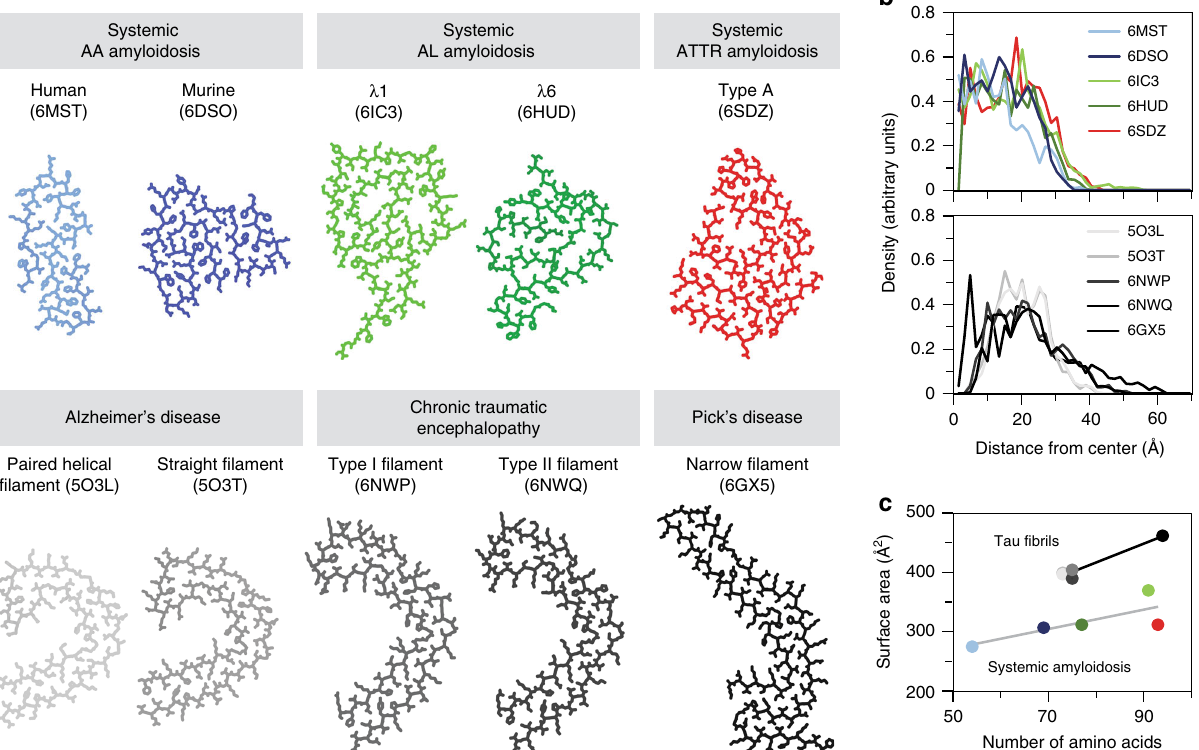
Fig. 5 Comparison of amyloid fi brils from systemic amyloidosis with tau-derived fi brils. a Views of the cross-sectional layers of fi ve fi brils from systemic AA 36 , AL 37,38 and ATTR amyloidosis and tau-derived fi brils from Alzheimer ’ s 39 , chronic traumatic encephalopathy 41 and Pick ’ s disease 40 . b Radial mass distributions of one protein stack. c Surface area of one protein stack plotted against the number of amino acids in the fi bril core. A linear fi t was added to guide the eye. The colour coding is kept consistent in all panels. Source data are provided as a Source Data fi le